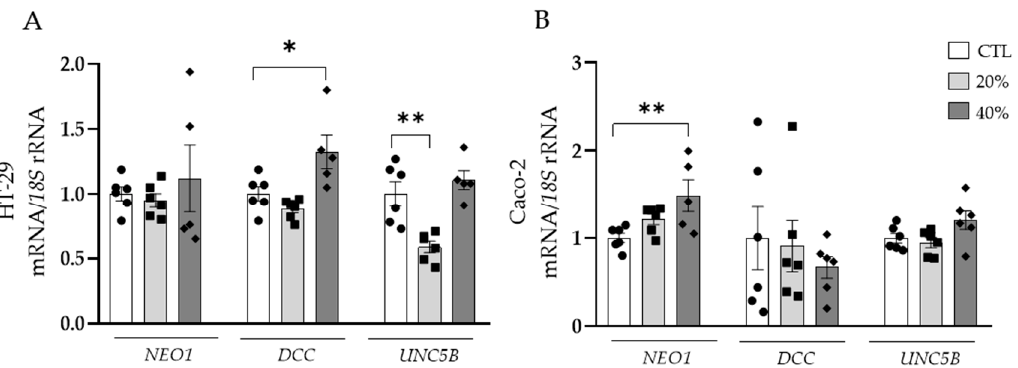
Figure 3. Gene expression levels of neogenin-1 ( NEO1 ), deleted in colorectal carcinomas ( DCC ) and uncoordinated-5 homolog family member B ( UNC5B ) in ( A ) HT-29 and ( B ) Caco-2 human colorectal cancer cell lines after the treatment with adipocyte conditioned media (ACM) for 24 h. Gene expression levels in untreated cells were assumed to be 1. Values are the mean ± SEM (n = 4–6 per group). Differences between groups were analysed by one-way ANOVA followed by Dunnett’s post hoc tests. * p < 0.05 and ** p < 0.01.